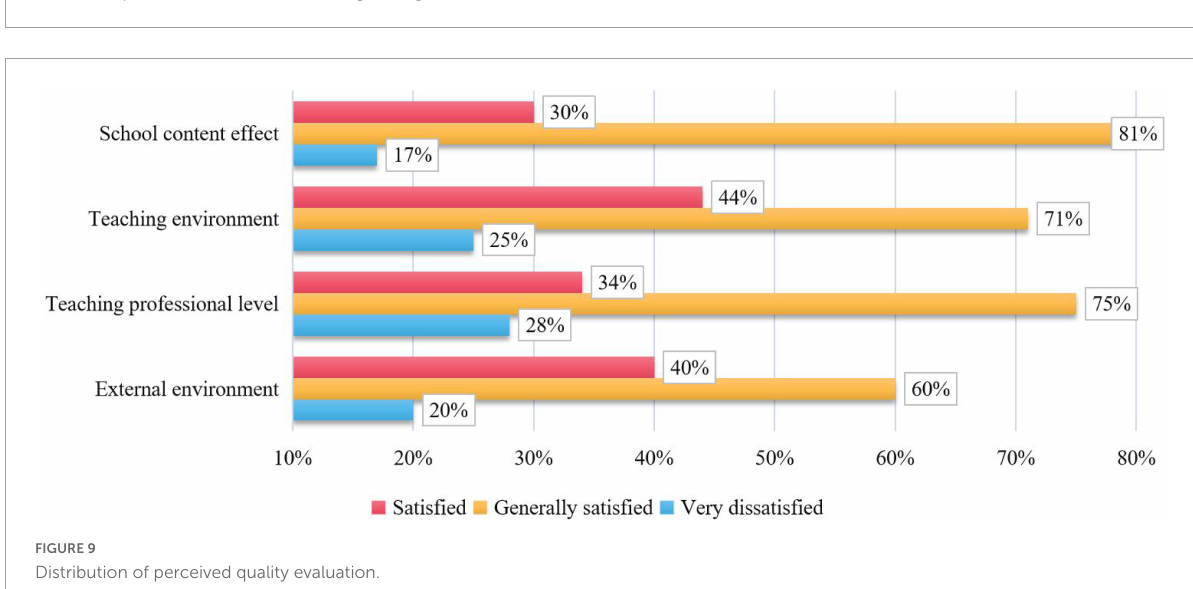
FIGURE8 Relationship between reasons for training and age.